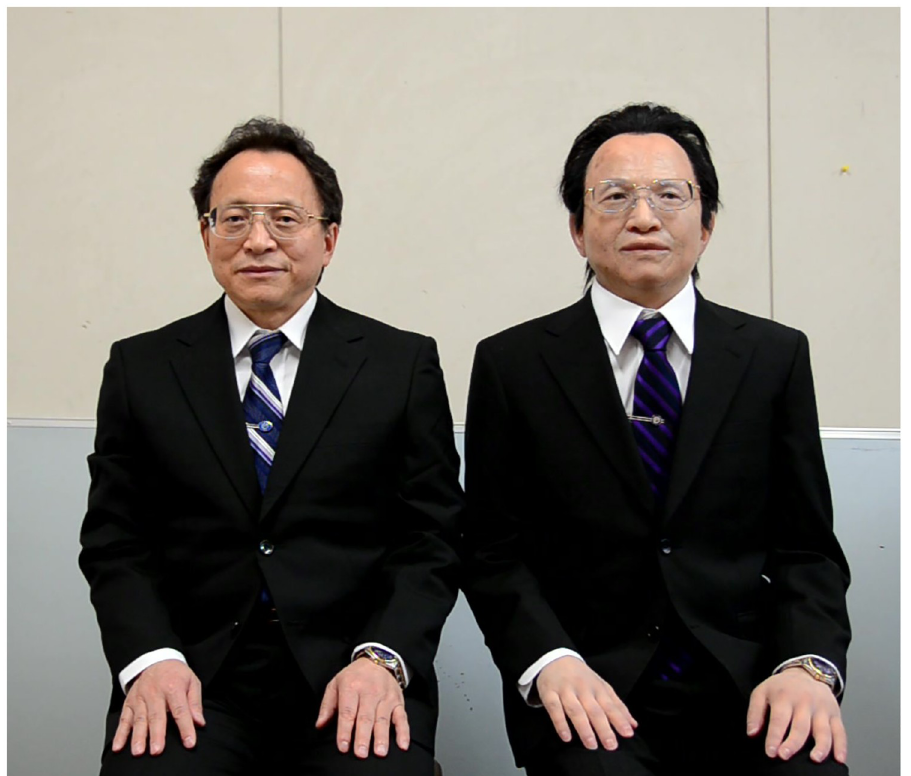
Fig 1. Prof. Ren (left) and his avatar robot REN-XIN (right).